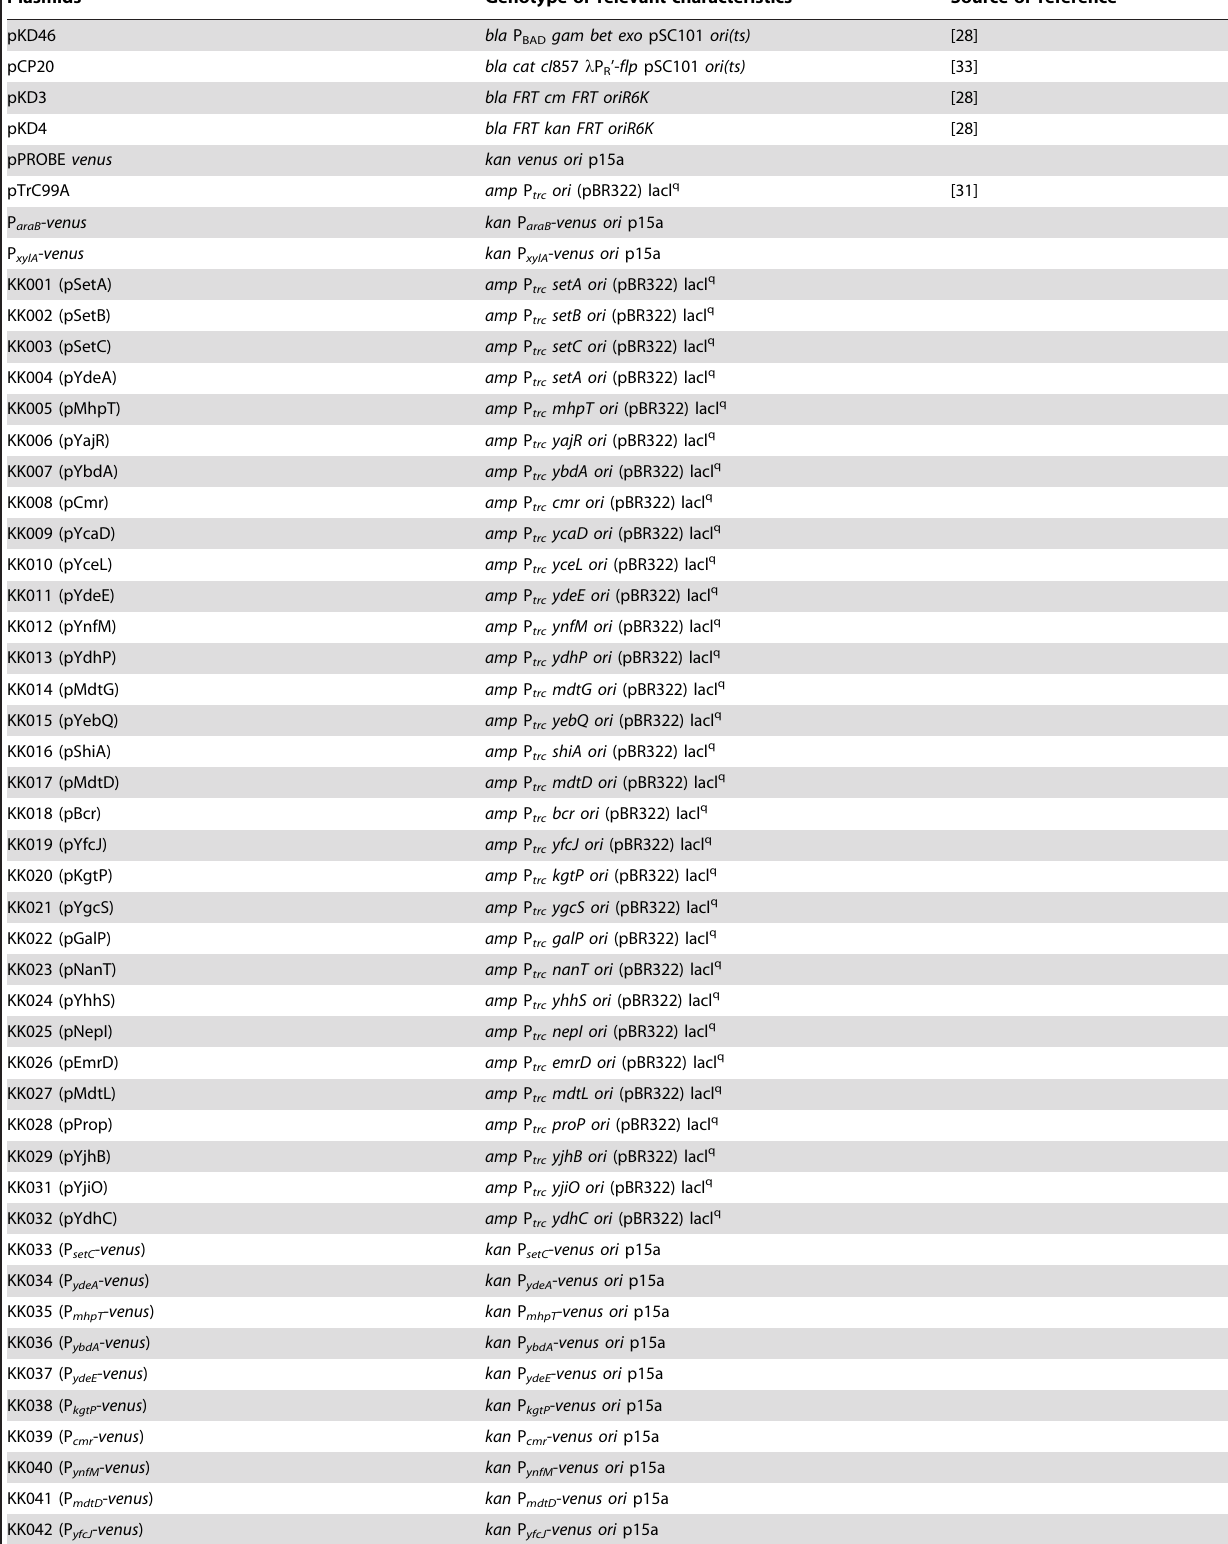
Table 4. Plasmids used in this work.